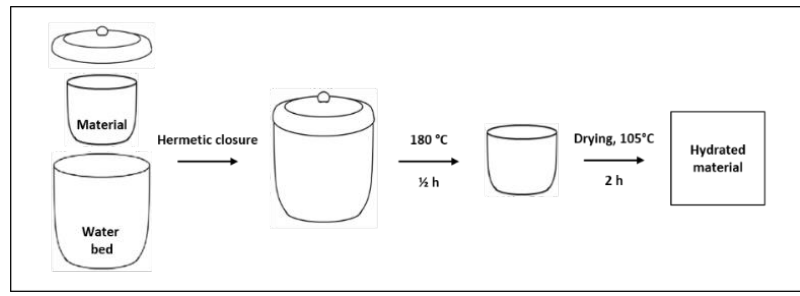
Figure 2. Schematized hydration procedure sequences.